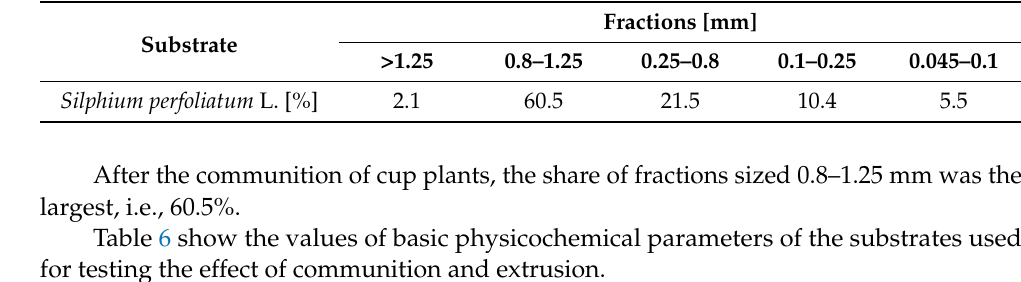
Table 5. The fractions obtained by communition of the